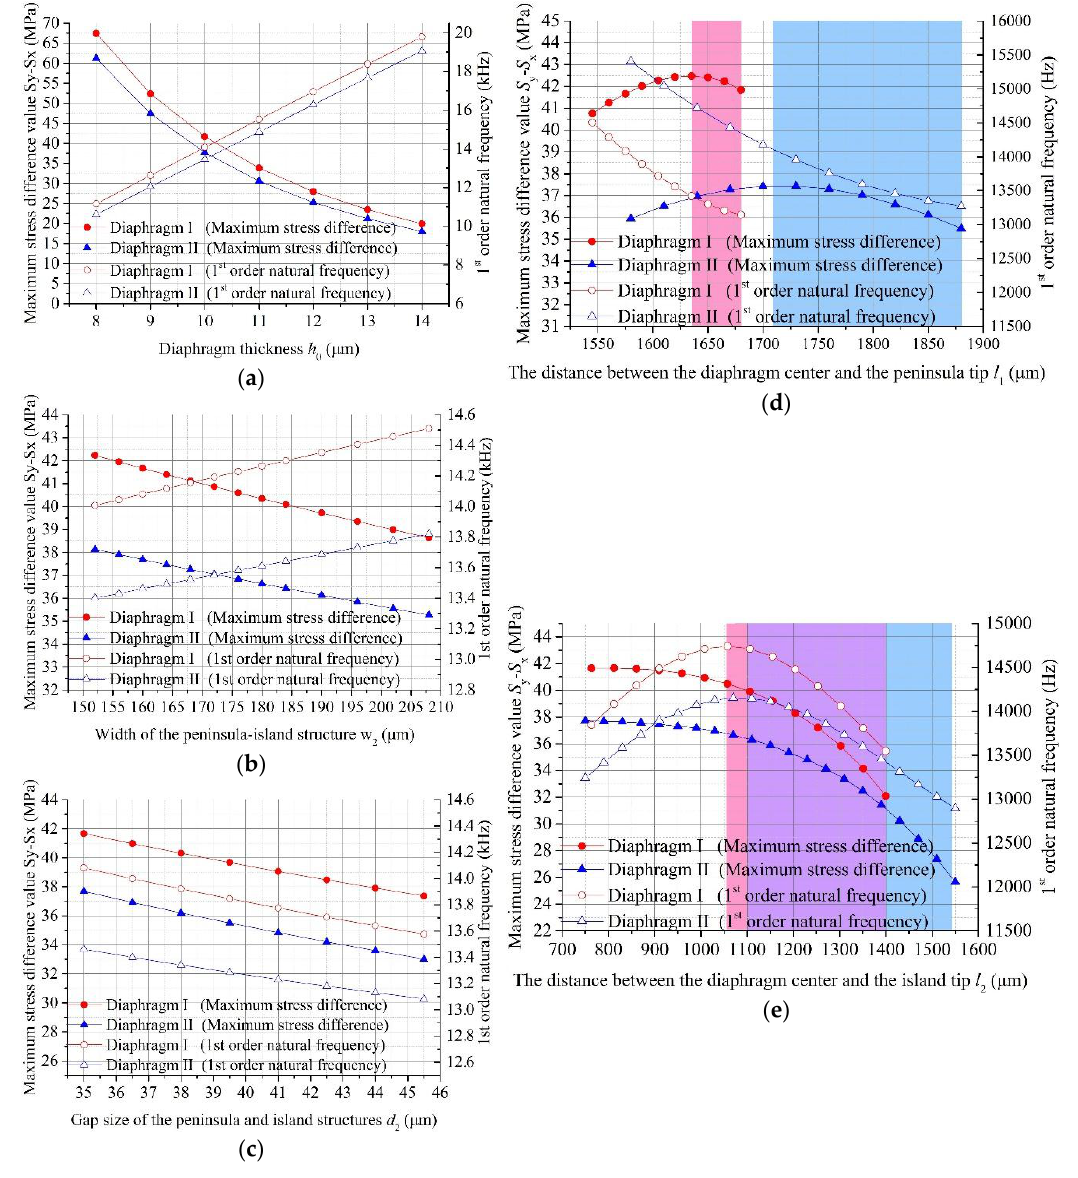
Figure 9. The effects of different geometrical parameters on S y − S x and f : ( a ) the effect of diaphragm thickness h 0 ; ( b ) the effect of peninsula-island structure width w ; ( c ) the effect of gap size d ; ( d ) the effect of l 1 ; ( e ) the effect of l 2 .